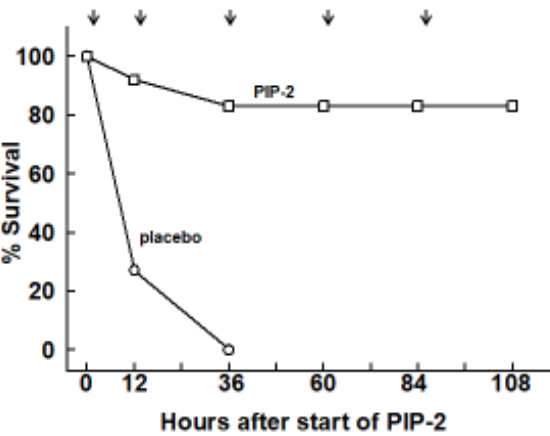
Figure 5. PIP-2 prevents mouse mortality with high dose LPS. Mice were administered LPS (15 µg/g body weight) by intratracheal instillation and divided into two groups. At 12 h after LPS, one group was given PIP-2 (2 µg/g body weight) in liposomes by intravenous injection (IV) while the other group (placebo) was given liposomes alone. The time of treatment initiation (12 h after LPS) is plotted as zero time. Treatment was repeated at 12, 36, 60, and 84 h after the initial dose of PIP-2, as indicated by the arrows. Surviving mice were sacrificed at 108 h after start of PIP-2 (120 h after LPS). n = 12 for placebo and n = 11 for PIP-2.